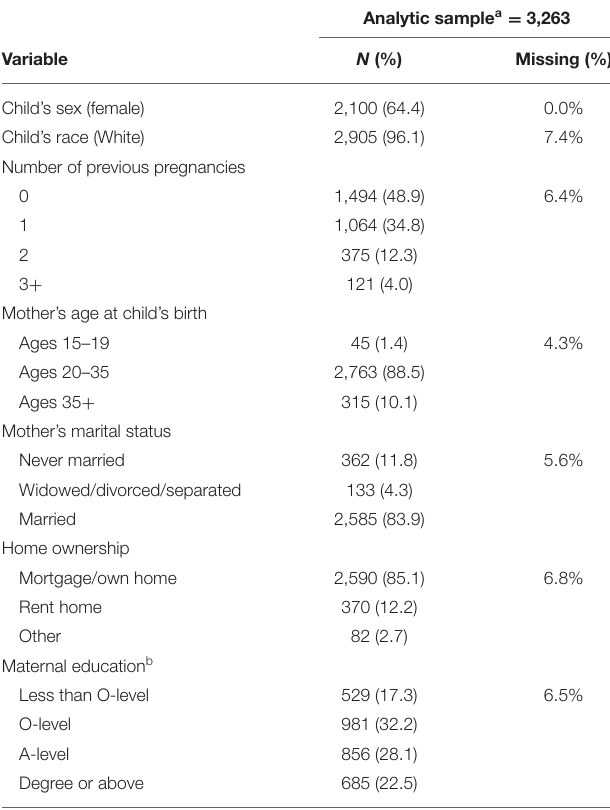
TABLE 1 | Baseline characteristics of participants in the analytic sample ( n =